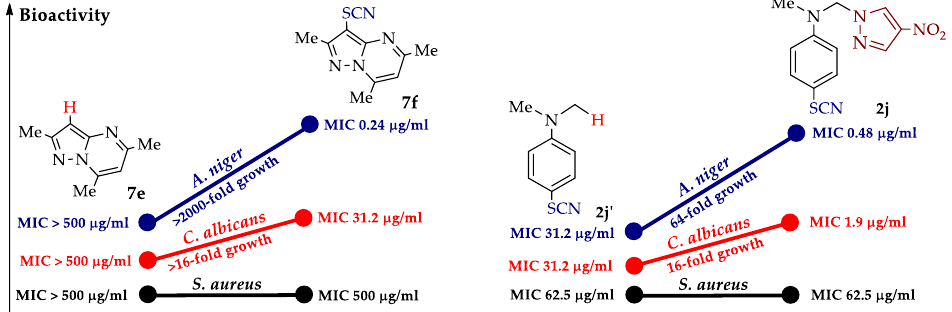
Figure 2. Effect of thiocyanate and pyrazole fragments on antifungal and antibacterial activity.